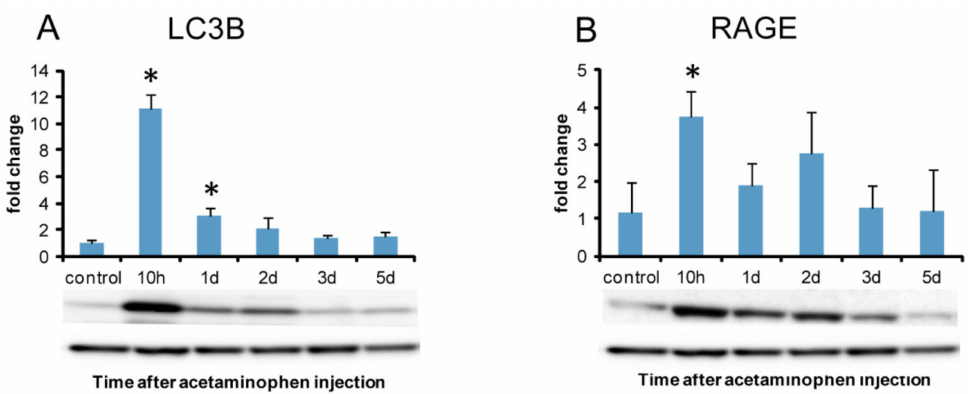
Figure 13. Western blotting analysis of LC3B and RAGE in APAP-induced rat hepatotoxicity. Significantly increased expression of LC3B protein is seen at hour 10 and day 1 ( A ) with a peak on day 10. RAGE protein expression is significantly increased at hour 10 ( B ). A representative band is shown at each examination point (A and B). GAPDH was used as the loading control (lower panel). Dunnett’s test; *, significantly di ff erent from controls at p < 0.05. Bar represents the mean ± SD. RAGE, receptors for advanced glycation end